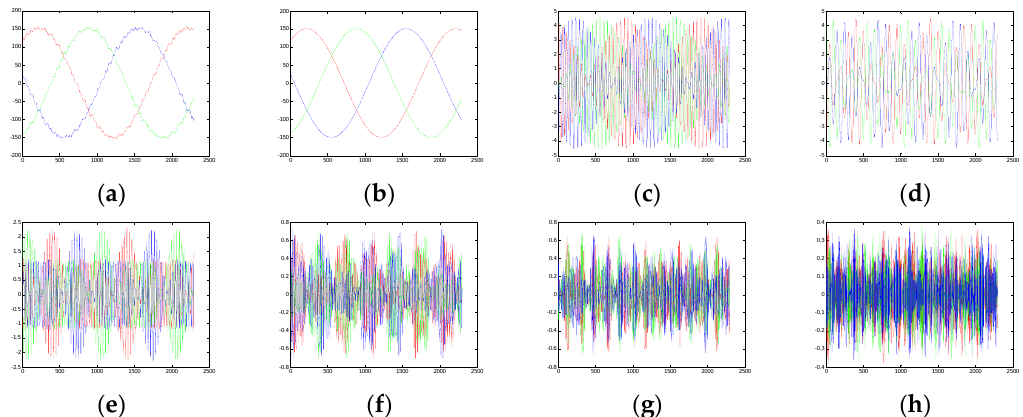
Figure 5. Waveforms of three-phase current and the mode coefficients serials under No. 1 state. ( a ) Waveform of three-phase current. ( b – h ) Waveforms of mode coefficients serials from 1st level to 7th level.